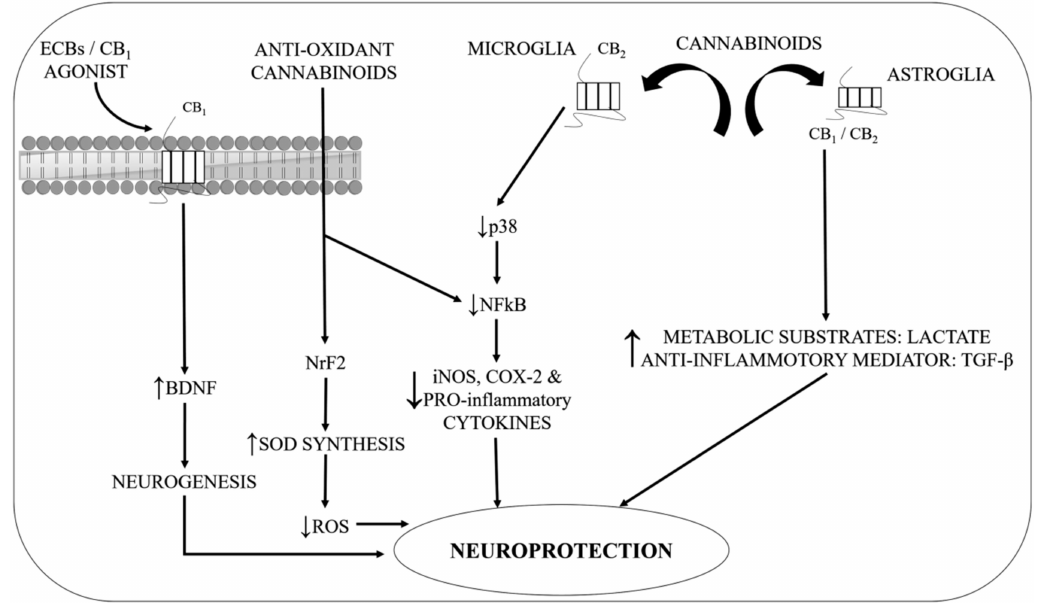
Figure 3. Probable mechanisms to demonstrate the neuroprotective action of